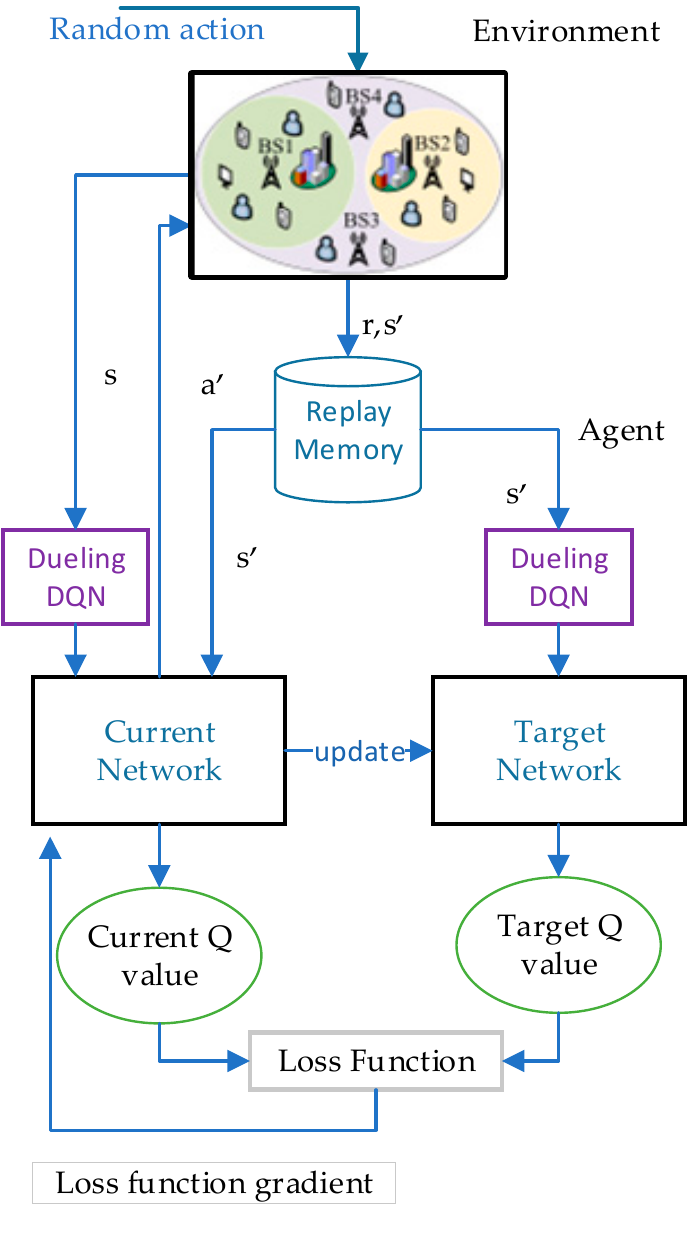
Figure 2. Algorithm flow diagram.